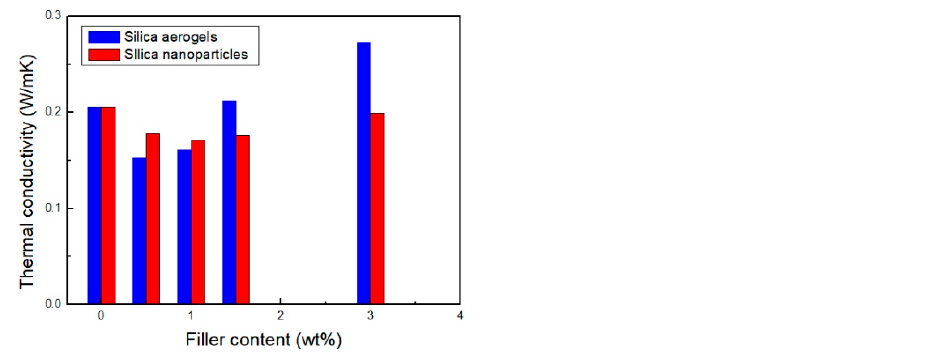
Figure 8. Thermal conductivity of PU foam and PU composite foams with silica aerogels and silica nanoparticles of different compositions.